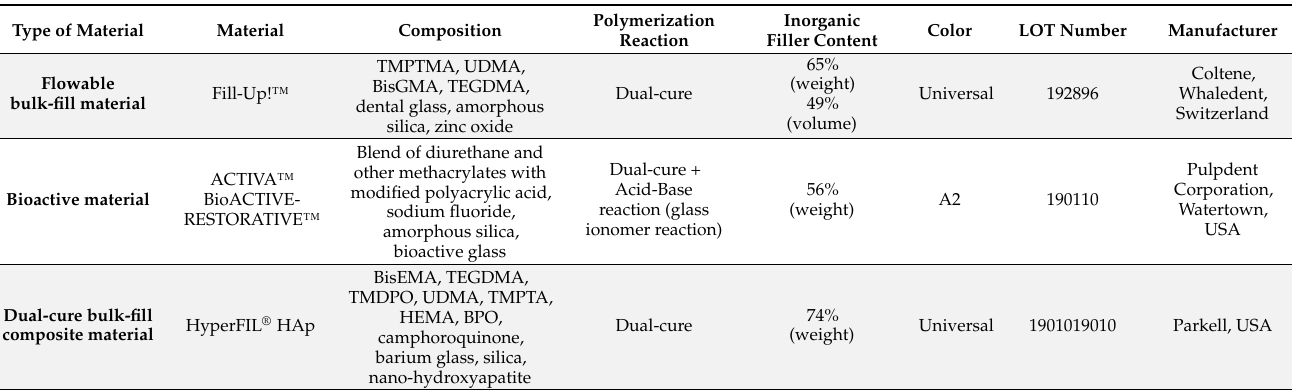
Table 1. Experimental materials used in the